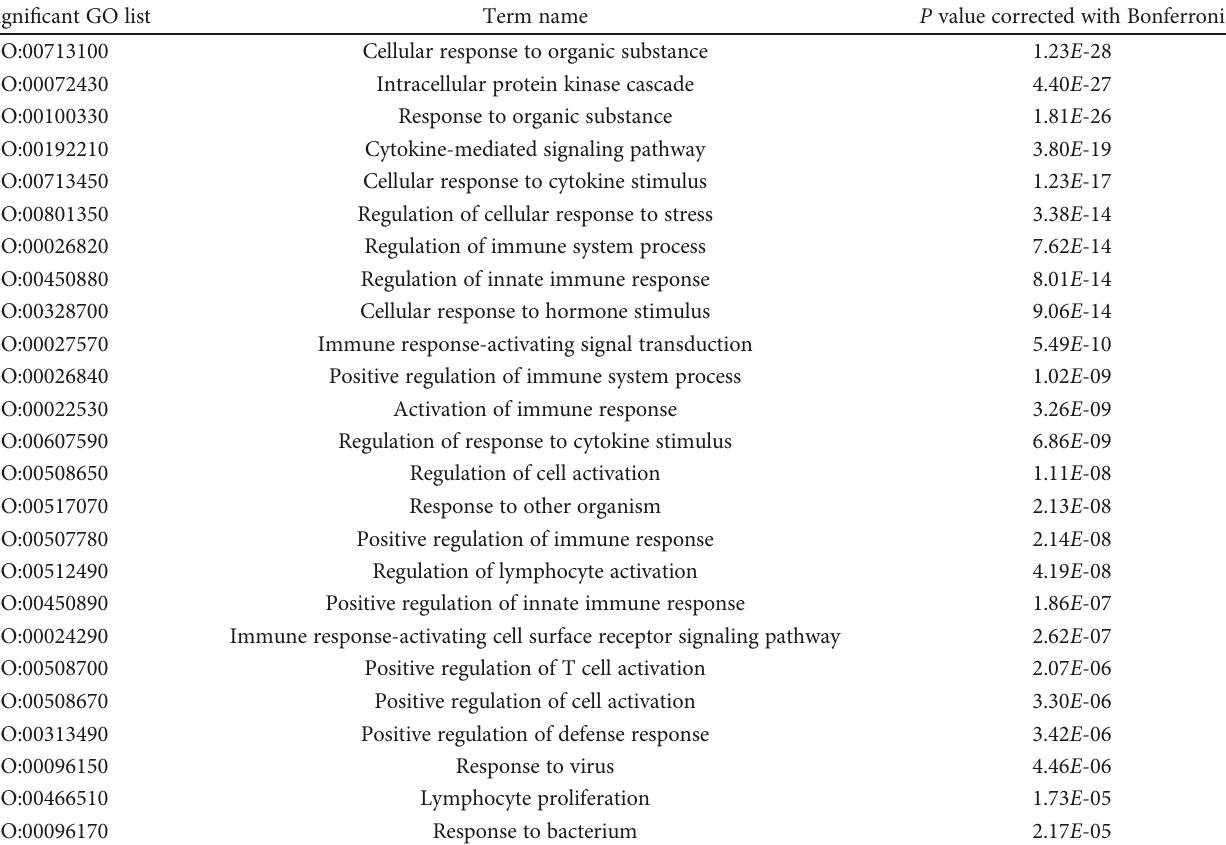
Table 4: The signi fi cant immune-related-enriched functional